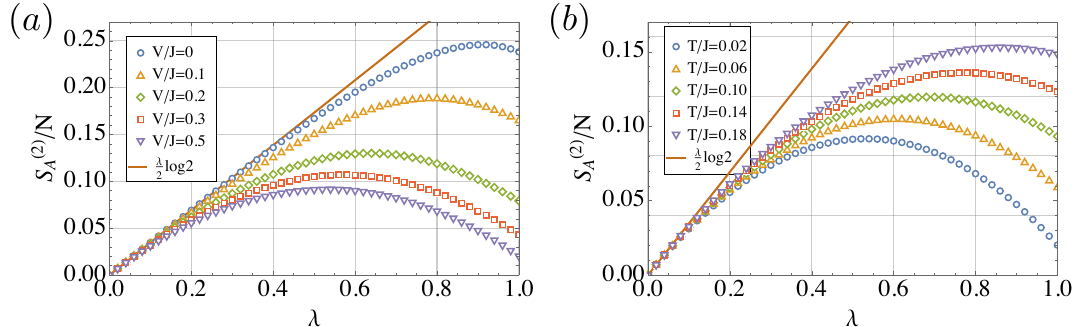
( 2 ) / N for different V / J with β J = 50 and A ( 2 ) / N for different temperature T / J with q = A